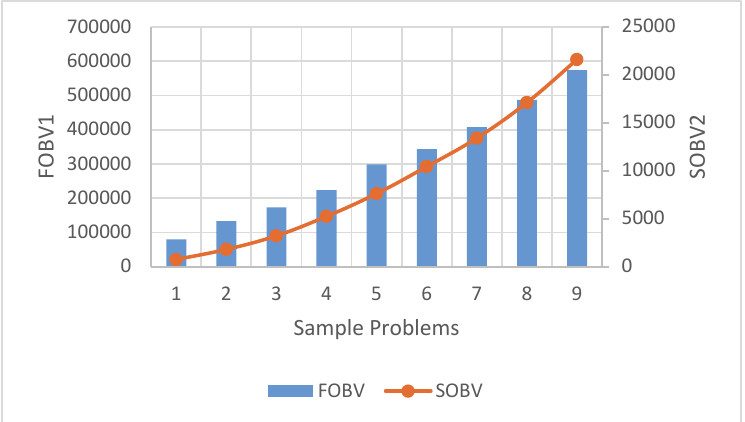
Fig. 13 . Changes in the first and second objective function in different sample problems by NSGA II